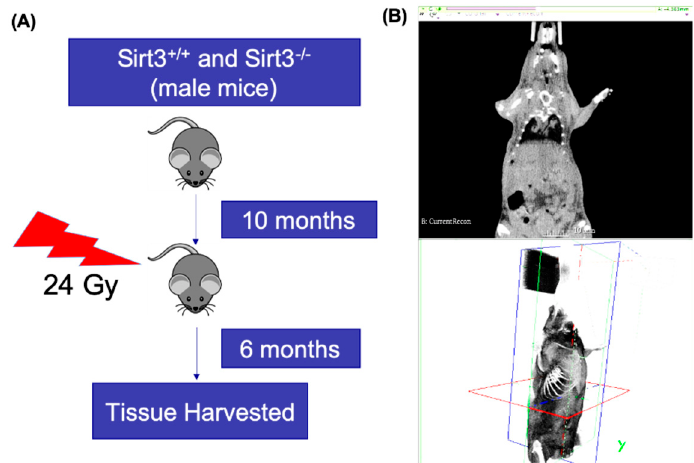
Figure 1. ( A ) Experimental timeline for the irradiation and tissue harvest from Sirt3 +/+ and Sirt3 − / − male mice. ( B ) Image guided irradiation of the liver using Small Animal Radiation Research Platform (SARRP).